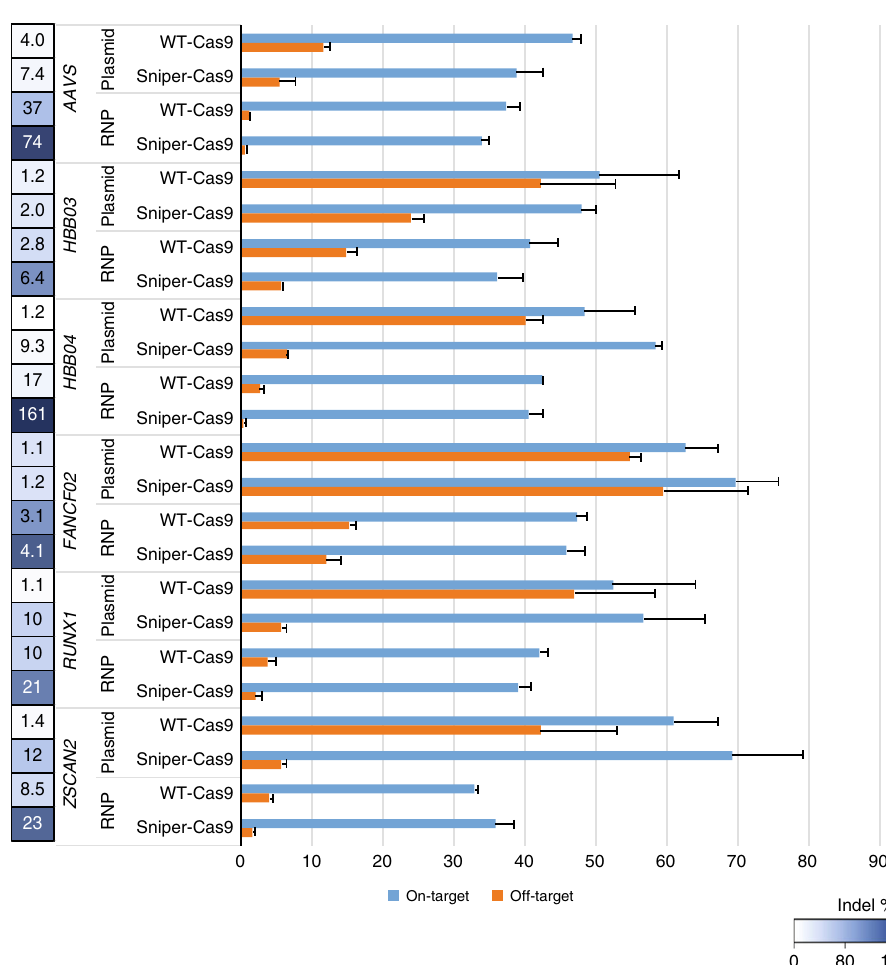
Fig. 3 On-target and off-target activities of WT-Cas9 or Sniper-Cas9 paired with a 20-mer guide sequence delivered via plasmid or RNP. Speci fi city ratios were determined by dividing the on-target activity by the off-target activity. Error bars indicate s.e.m. ( n =